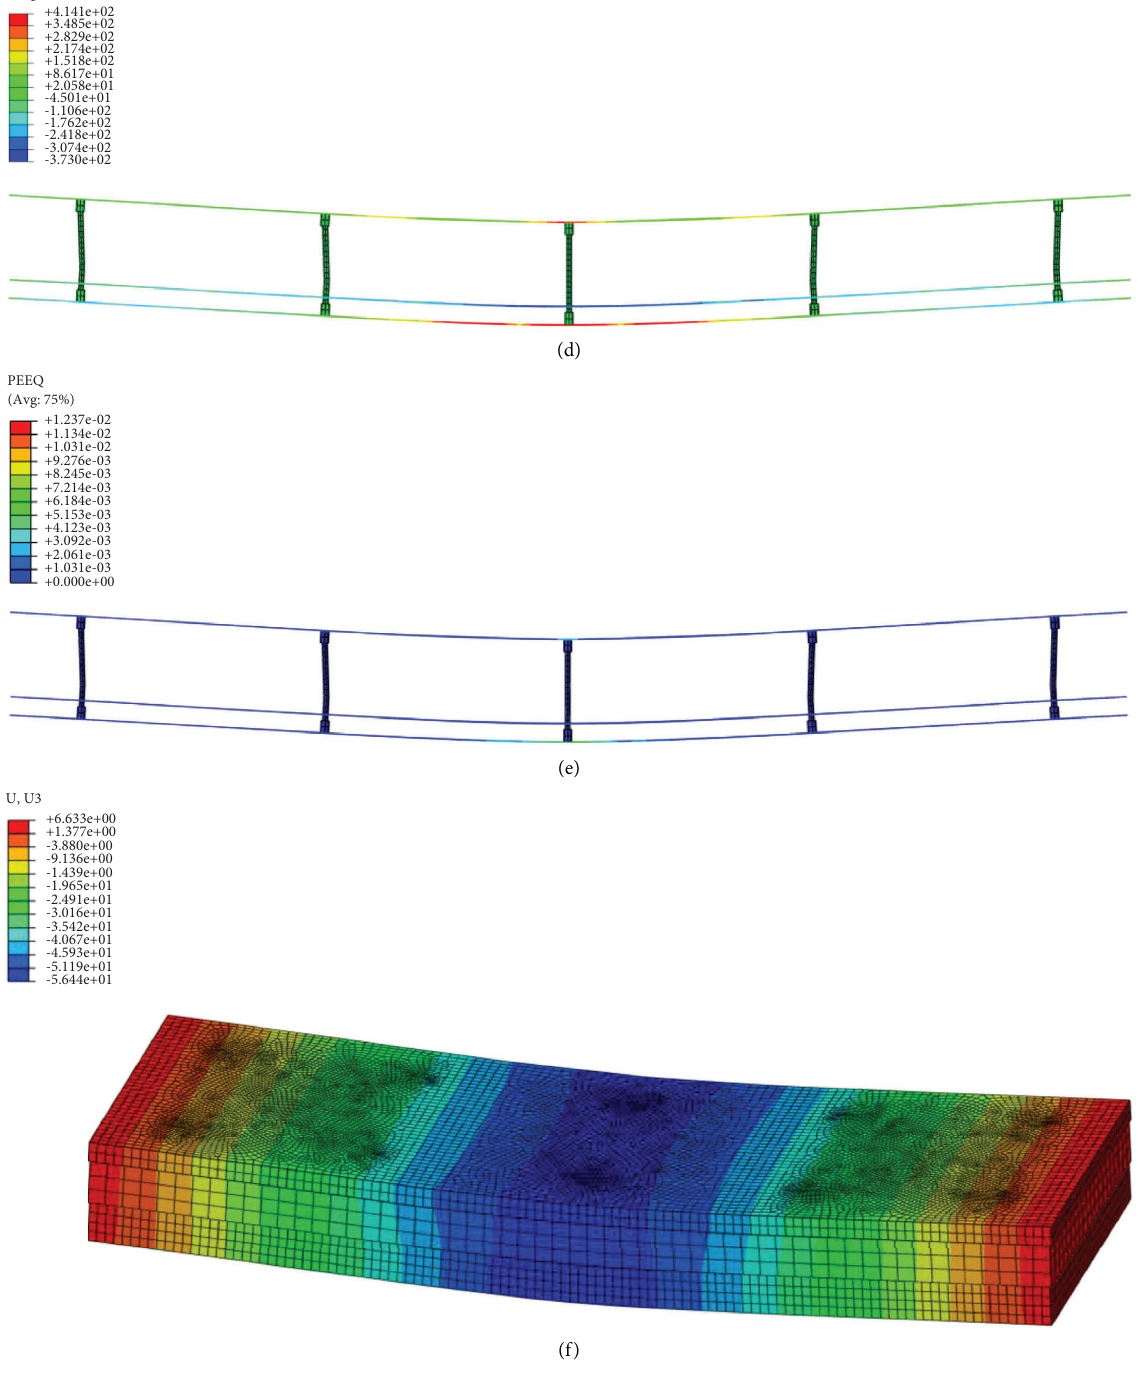
Figure 13: Simulated damage and contours of stress, strain, and displacement of G24A0.2-I at failure. (a) Stress contour of G24A0.2-I, (b) tension damage of G24A0.2-I, (c) tension damage on bottom wythe of G24A0.2-I, (d) stress contour of steel mesh of G24A0.2-I, (e) strain contour of steel mesh of G24A0.2-I, and (f) displacement contour of